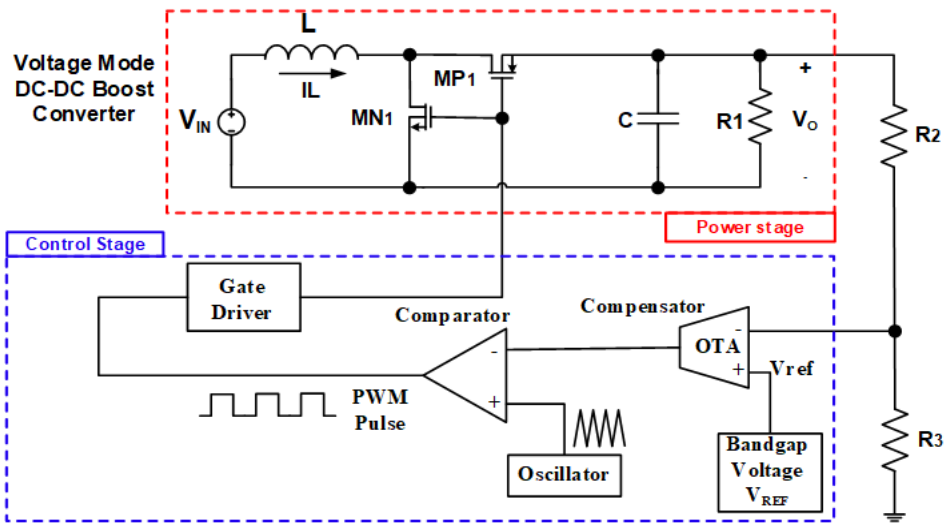
Figure 1. Block diagram of the proposed voltage–mode boost DC–DC converter.